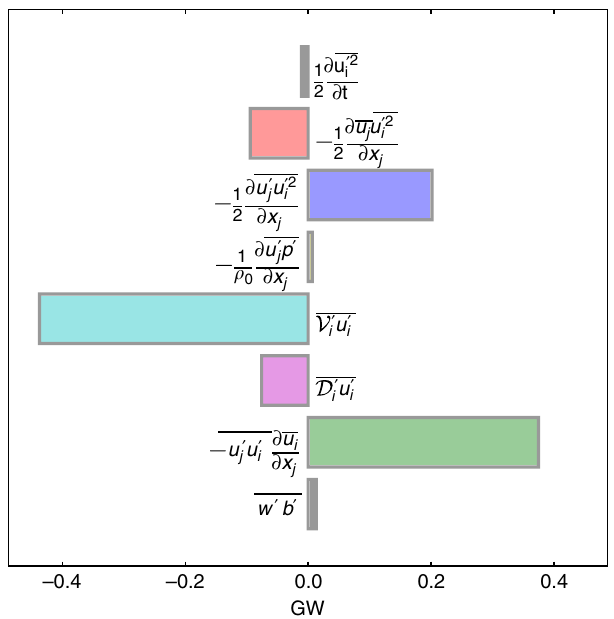
Figure 5 | Eddy kinetic energy budget. Volume integral of the EKE balance equations terms (equation 1) over the domain plotted in Fig. 4a. Units for energy rates are GW (10 9 W). The main source of EKE is the conversion from mean to eddy kinetic energy due to centrifugal instability (cid:2) u 0 and the main sink is the vertical mixing V 0